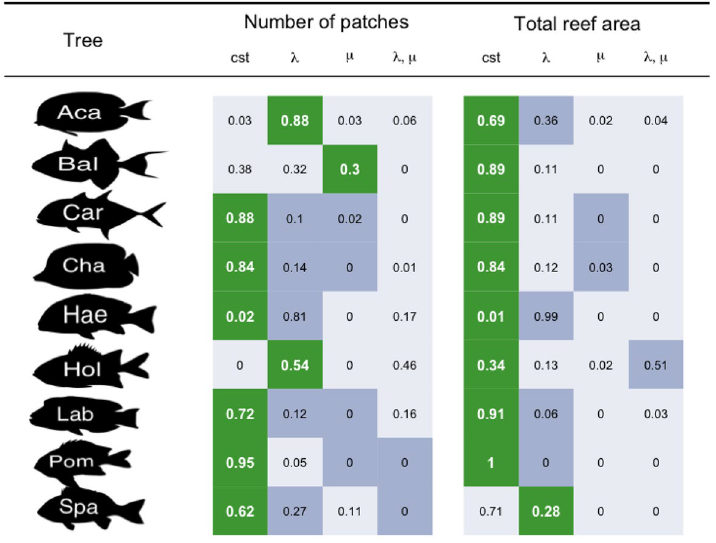
Table 2. Influence of the paleo-environment on the speciation and extinction rates of each phylogeny. The table is divided in two parts: one for the influence of the number of patch through time and one for the influence of the total are through. For each taxa, the cell in green represents the best model selected with the AICc approach on the consensus tree; The cells in dark grey represent the models based on the consensus tree, that have a (cid:31) AICc lower than two; The cells in light grey represent the models based on the consensus tree, that are rejected by the AICc approach. The proportions represent the frequency of selection of each model in the posterior distributions with the AICc approach. For each environmental variable, the column ‘cst’ represents the model 1 (pure birth–death ), the column ‘λ’ represents the models 2.1 and 2.2 ( environmental birth–death with the speciation rate dependant on the environmental variable), the column ‘μ’ represents the models 3.1 and 3.2 ( environmental birth–death with the extinction rate dependant on the environmental variable) and the column ‘λ,μ’ represents the models 4.1 and 4.2 ( environmental birth–death with both speciation and extinction rate dependant on the environmental variable). Aca Acanthuridae, Bal Balistoidea, Car Carangoidea, Cha Chaetodontidae, Hae Haemulinae, Hol Holocentridae, Lab Labridae, Pom Pomacentridae, Spa